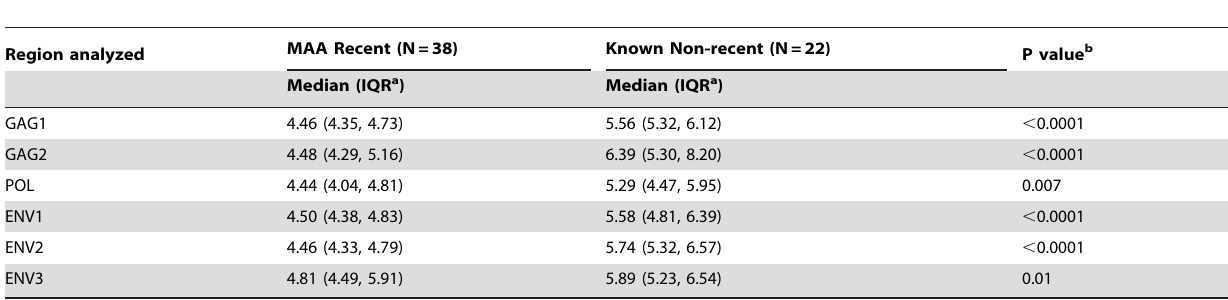
Table 3. Comparison of HIV diversity in women with MAA recent versus known non-recent HIV infection at enrollment.*